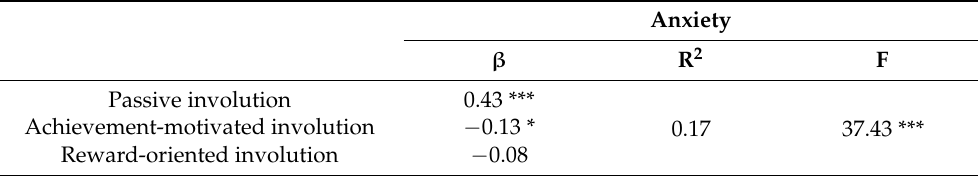
Table 11. Regression analysis of anxiety on involution involvement ( n =